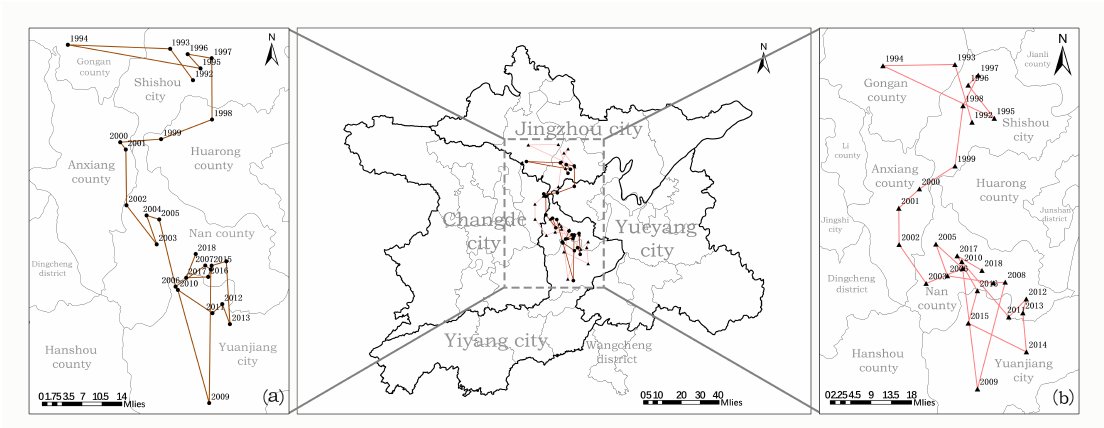
Figure 12. ( a ) Shows weightless gravity center offset, ( b ) shows weight gravity center offset.